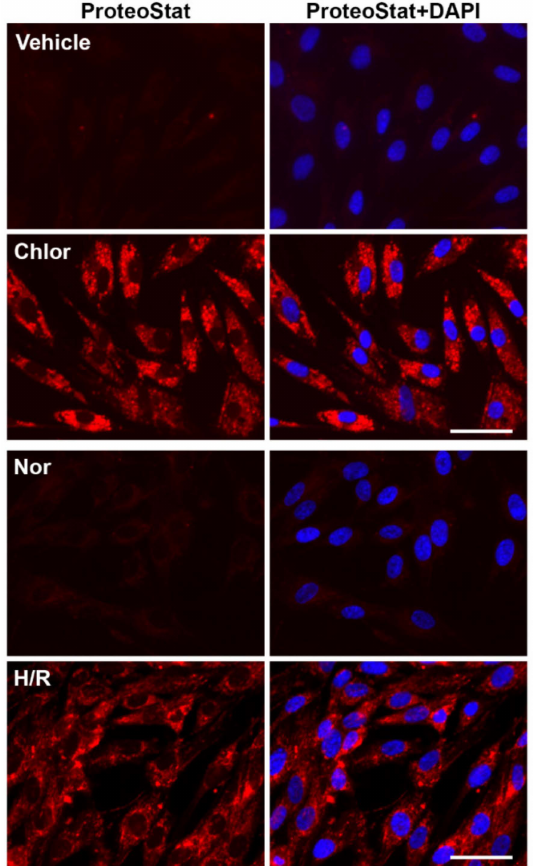
Figure 4. Accumulation of protein aggregates in chloroquine- and H/R-treated PHTs. PHTs were treated with vehicle or chloroquine and fixed at 12 h or exposed to normoxia (Nor) or H/R and fixed at day 3. Fixed cells were stained with ProteoStat dye (red). The nuclei were stained with DAPI (blue). The images were representatives of at least 3 independent experiments. Bar: 20 µ